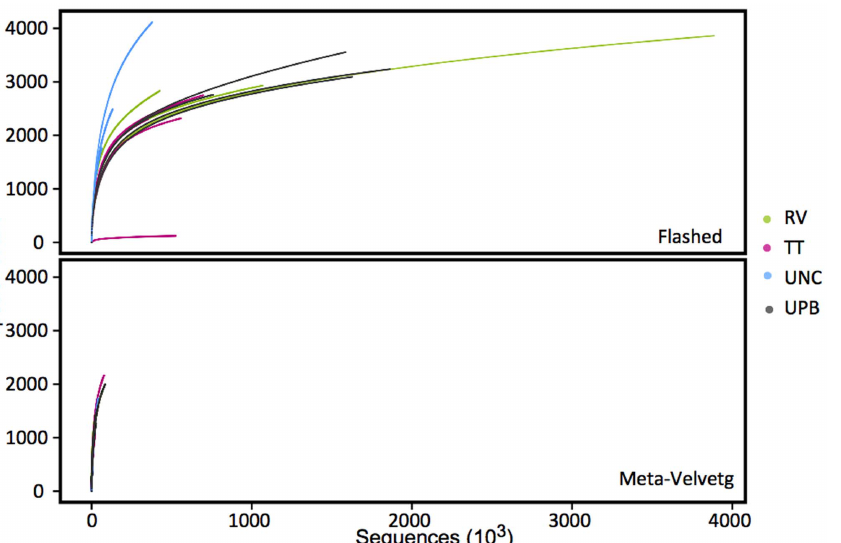
Figure 1. Rarefaction plots illustrating the increase in taxa identified as a function of different sequencing depths for a) flashed and b) Meta-Velvetg reads.